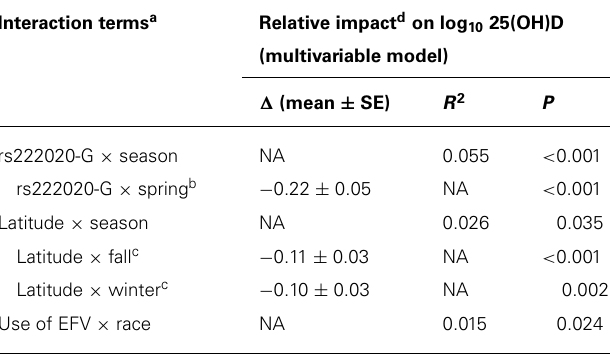
Table 6 |Three independent interaction terms identified by multivariable analyses.